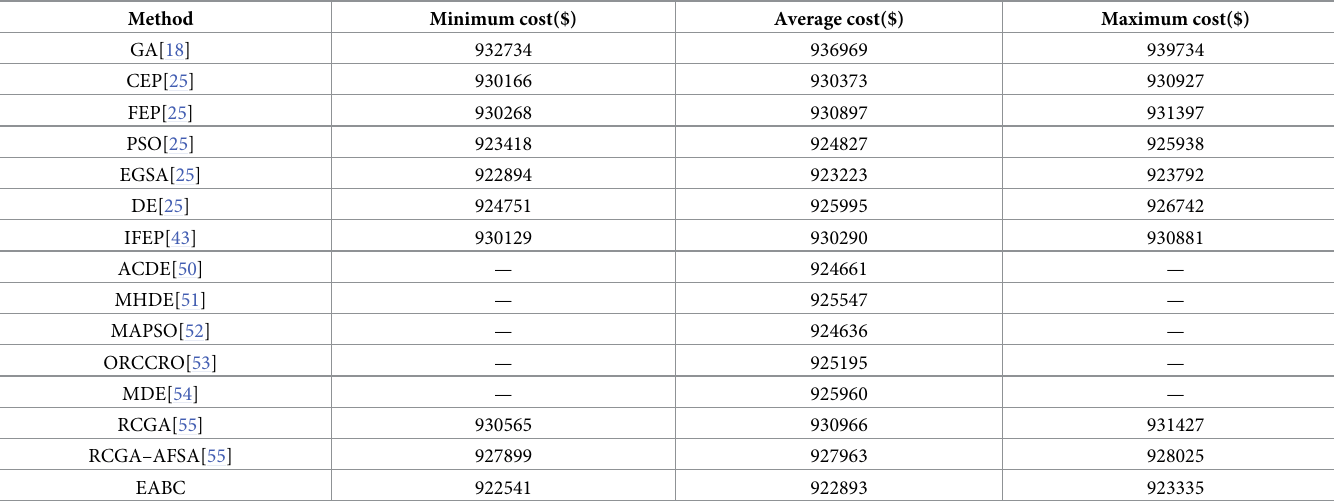
Table 9. Comparison with other algorithms.